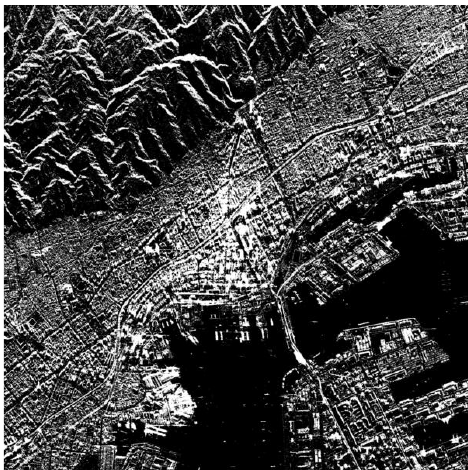
Figure 3. Classification result using TP and P v before closing in study area 1